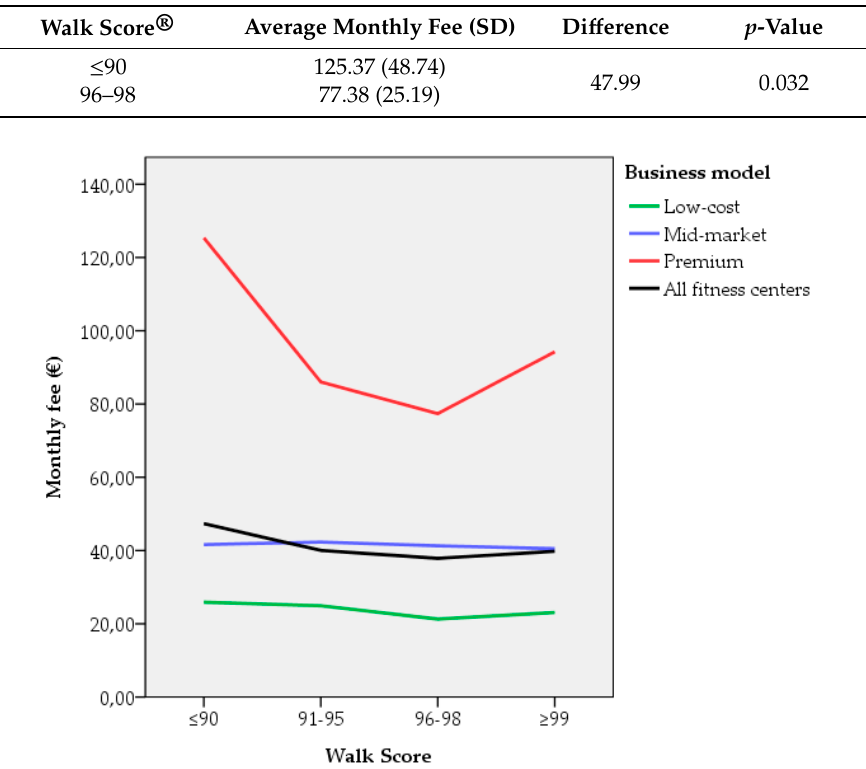
Table 2. Monthly fee t -test in premium centers according to Walk Score ® .